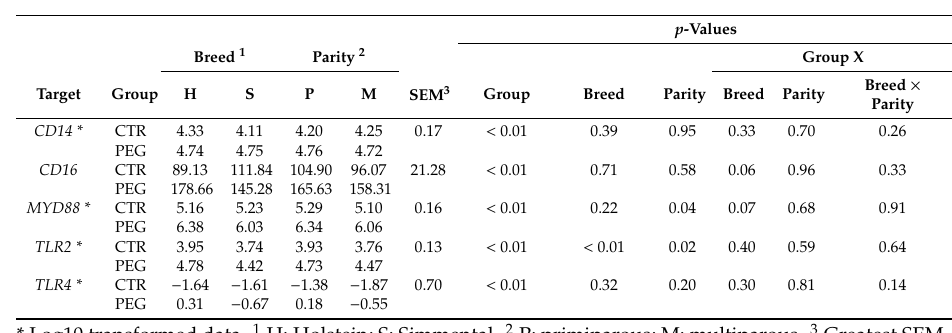
Table 1. LSM of arbitrary mRNA abundance for genes related to recognition and immune mediation functions in whole blood leukocytes from Simmental and Holstein cows treated with pegbovigrastim (PEG) or saline (control (CTR) at approximately Day 7 relative to calving and within 24 h on the day of calving.